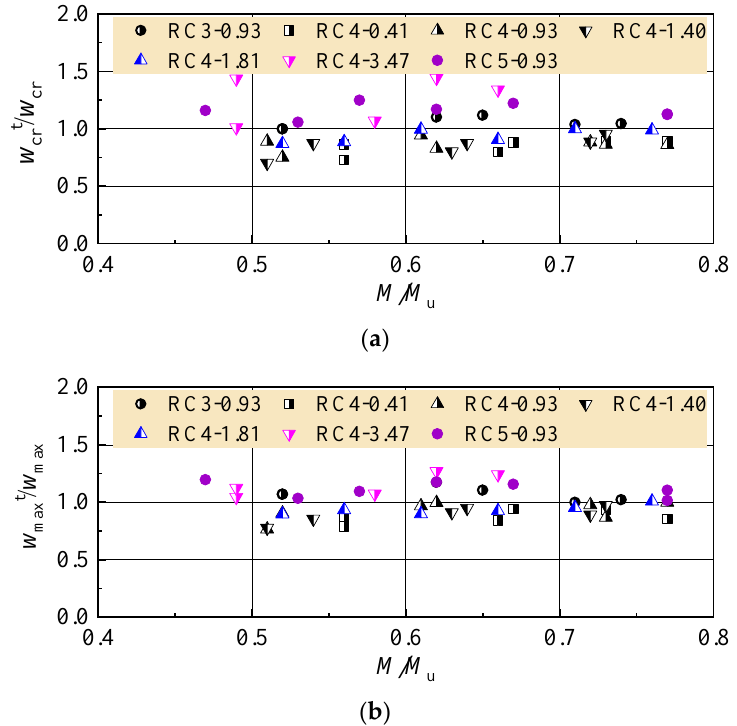
Figure 6. Ratios of test to calculated values: ( a ) average crack width; ( b ) maximum crack width.